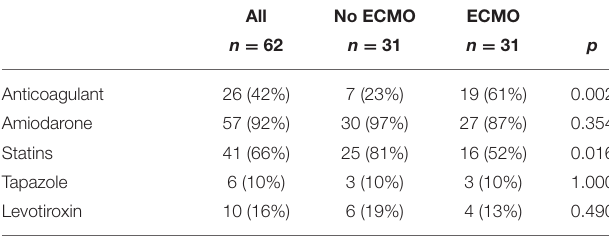
TABLE 1 | Patient characteristics by study groups.